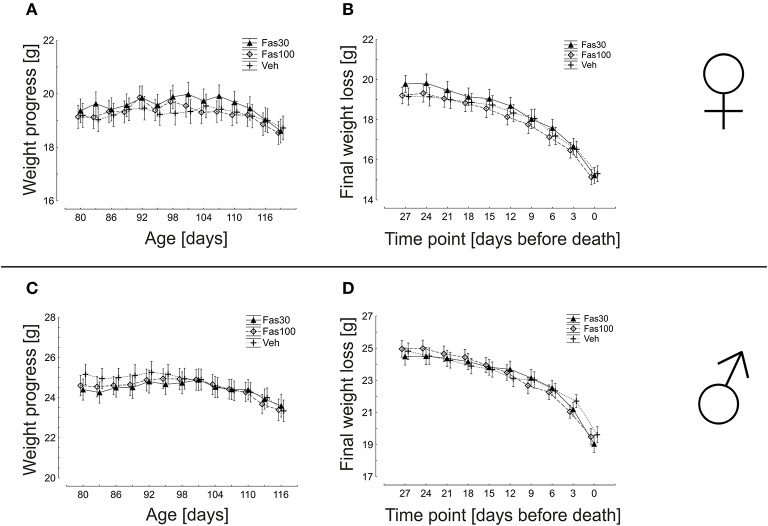
Weight dynamics in SOD1G93A transgenic mice orally treated with 30 mg/kg Fasudil (Fas30), 100 mg/kg Fasudil (Fas100) or with vehicle (Veh). Depicted are female (Fas30 n = 14, Fas100 n = 15, Veh n = 14) (A,B) and male (Fas30 n = 11, Fas100 n = 12, Veh n = 12) (C,D) cohorts.